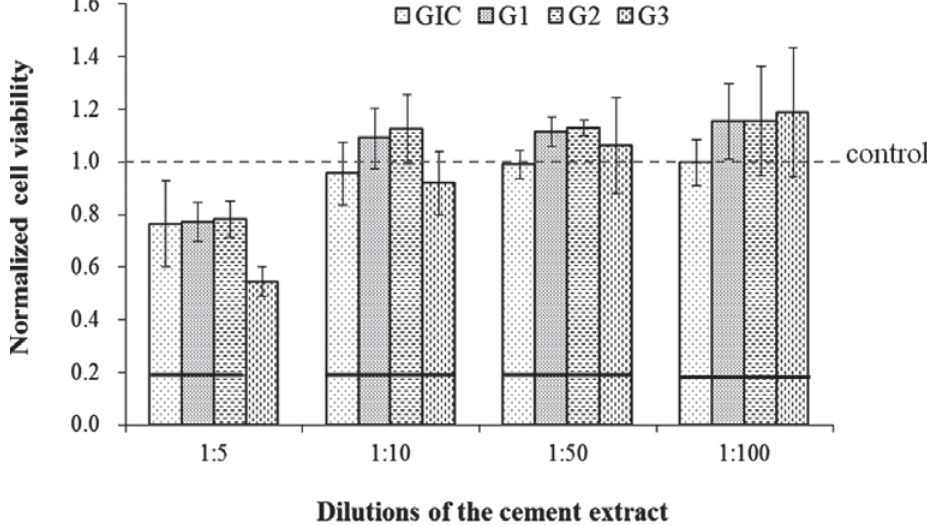
Figure 5- Results of the normalized cell viability to the control (no extract) by CCK-8 test. Horizontal bars indicate no (cid:15)(cid:5)(cid:16)(cid:7)(cid:5)(cid:17)(cid:18)(cid:9)(cid:7)(cid:8)(cid:11)(cid:13)(cid:5)(cid:19)(cid:19)(cid:14)(cid:4)(cid:14)(cid:7)(cid:18)(cid:14)(cid:11)(cid:12)(cid:14)(cid:8)(cid:25)(cid:14)(cid:14)(cid:7)(cid:11)(cid:16)(cid:4)(cid:3)(cid:22)(cid:26)(cid:15)(cid:11)(cid:9)(cid:8)(cid:11)(cid:14)(cid:9)(cid:18)(cid:27)(cid:11)(cid:13)(cid:5)(cid:10)(cid:22)(cid:8)(cid:5)(cid:3)(cid:7)(cid:11)(cid:20)(cid:21)(cid:22)(cid:23)(cid:14)(cid:24)(cid:11)(cid:8)(cid:14)(cid:15)(cid:8)(cid:28)(cid:11)(cid:26)(cid:29)(cid:30)(cid:31)(cid:30)!"